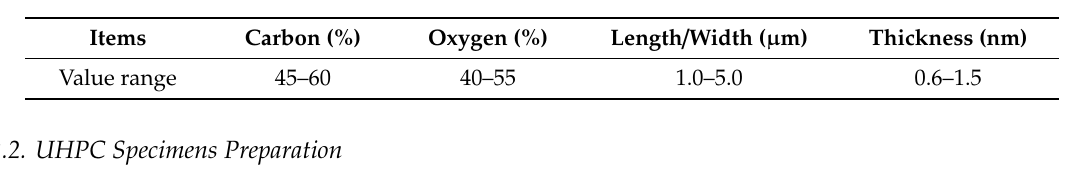
Table 2. The composition and dimensions of graphene oxide